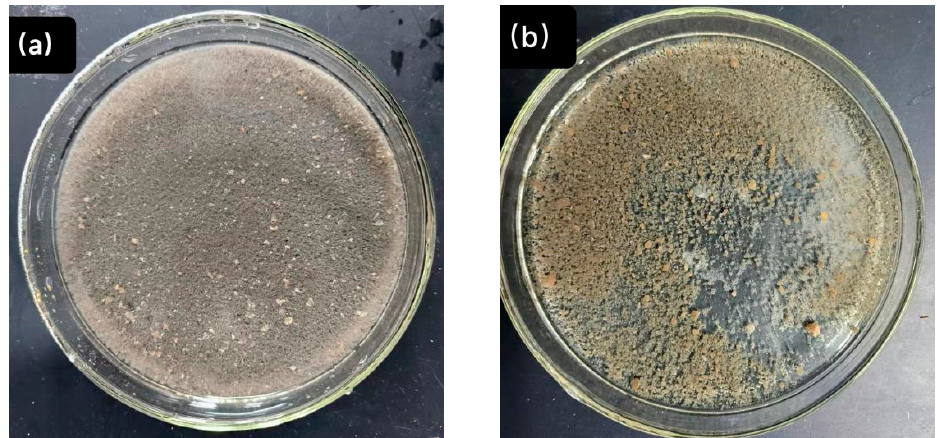
Figure 7. Variations of sludge morphology: ( a ) The S 0 -SADN operation stage; ( b ) The ANAMMOX start-up stage.